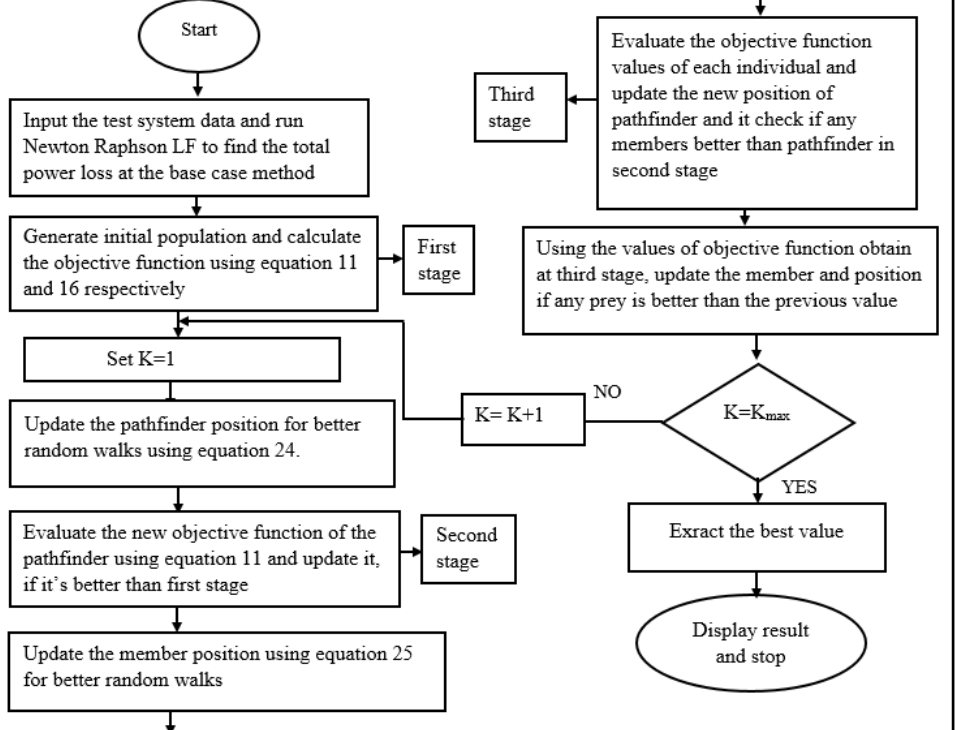
Figure 1. Flow chart of the proposed IPFA.